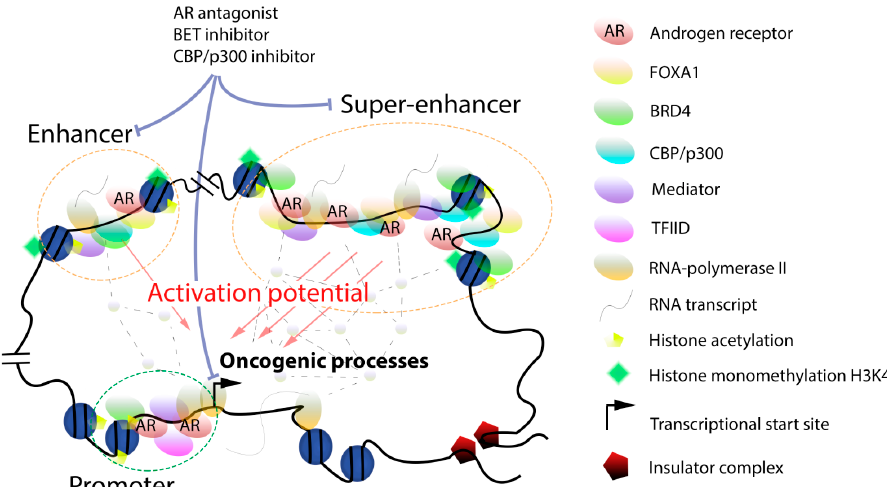
Figure 1. Interaction model for factors associated with enhancer and super-enhancer function in prostate cancer. The transcription activation potential of enhancers and super-enhancers is correlated to the levels of their associated factors. Transcription regulatory elements physically interact with their target genes and enable the local formation of a dense network of transcription factors (dotted lines with grey nodes), ultimately leading to sustained transcription by RNA Pol II. Compounds such as AR antagonists and BET or CBP/p300 inhibitors can block factors associated with enhancer or super-enhancer function.